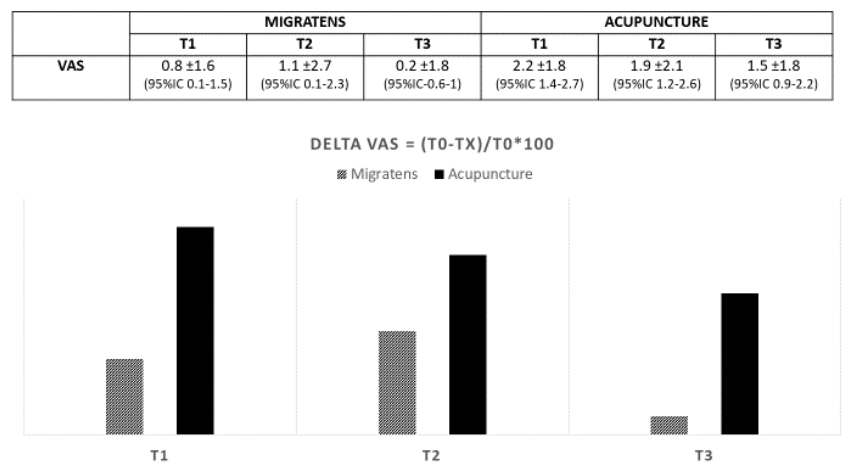
Figure 6. Reduction difference in VAS values in the two treatment groups during observation (values are expressed as mean difference ±SD).